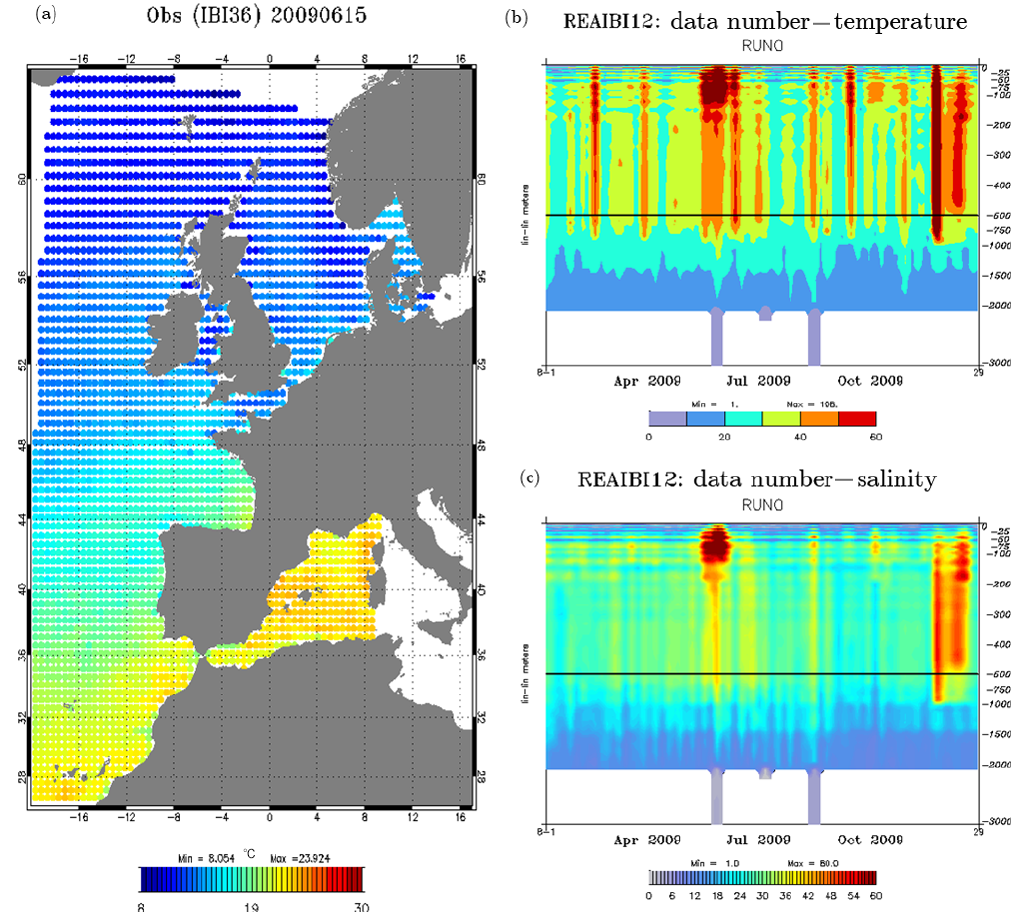
Figure 1. Temperature and salinity simulated data. (a) Sea surface temperature from the NR (15 June 2009). Number of temperature (b) and salinity (c) data during the year 2009 (corresponding to the CORA3.2 database in situ data